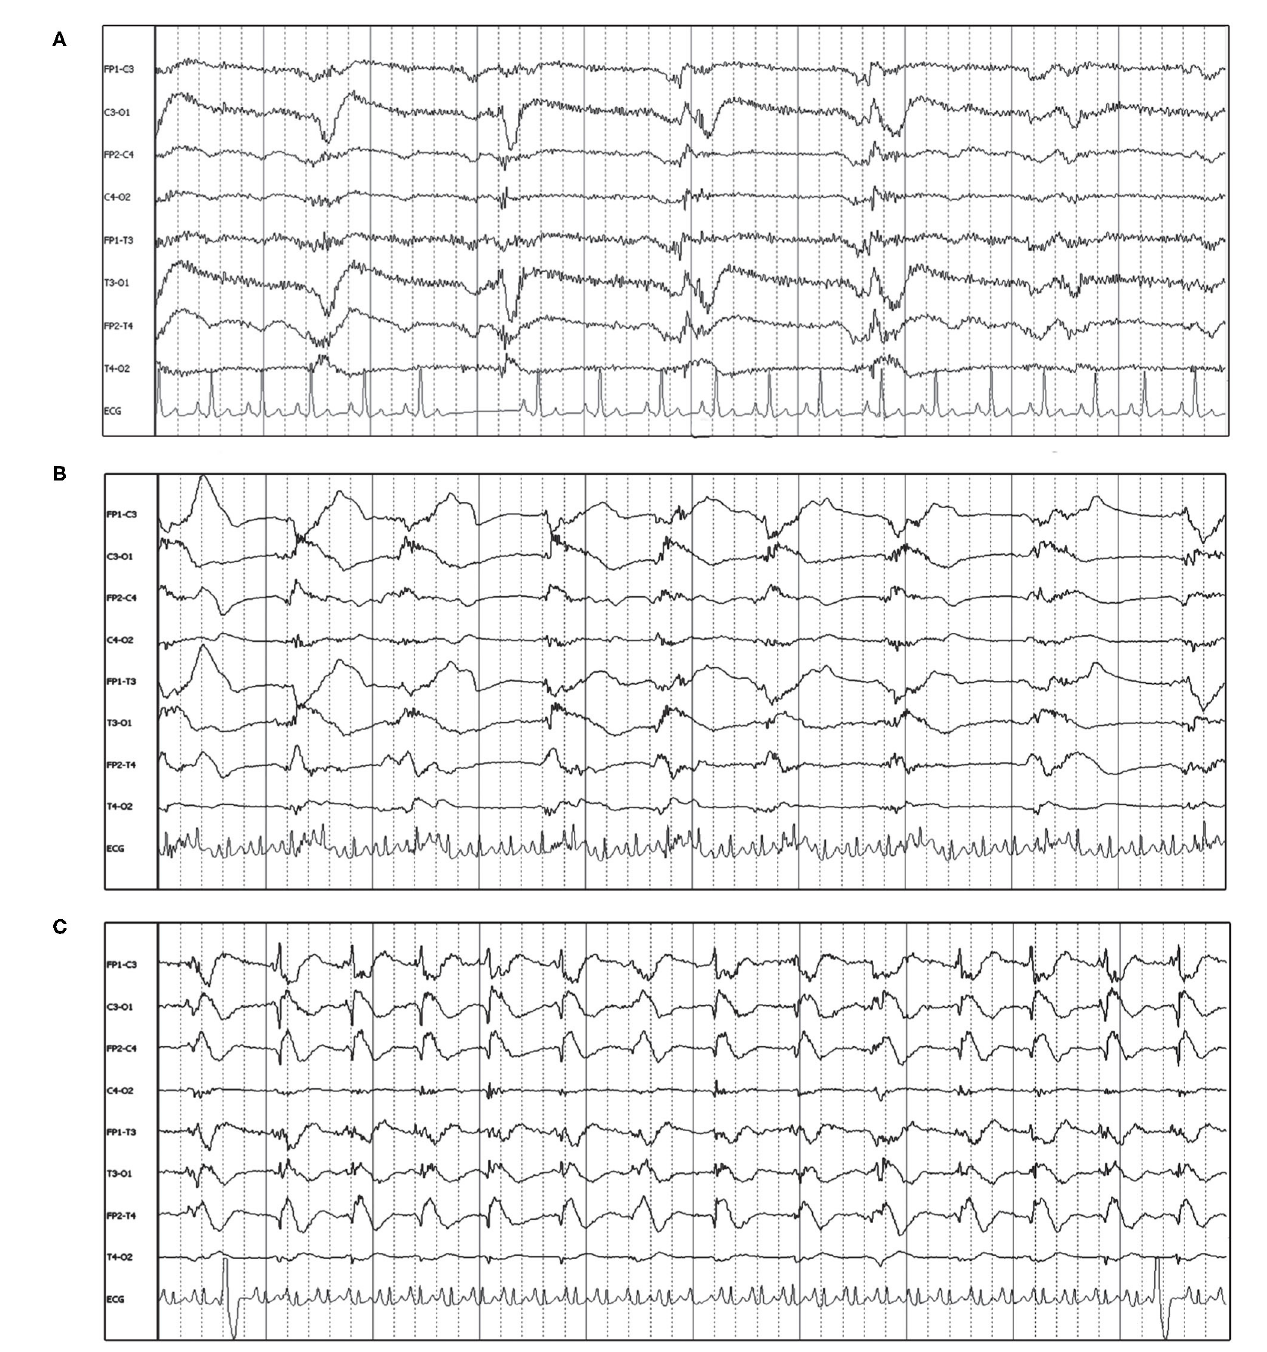
FIGURE4 EEG epochs over the course of 45min in a 10 year old Boxer with hypoglycemia and SE demonstrating evolution in PD frequency as well as change in morphology to a more ictal-appearing pattern. Bipolar montage. (A) PD frequency is about 0.5Hz, some with a triphasic morphology. There is no apparent phase reversal, but the discharge has the highest amplitude on the left side, and end-of-chain would localize to O1 (HF 35Hz, sensitivity 7 uV/mm). (B) Frequency increases to almost 1Hz, along with a change in morphology and increased amplitude—note the change in sensitivity. Discharges are still lateralized (LPDs), with phase reversal noted in the left hemisphere at T3 and C3 (HF 15Hz, sensitivity 50 uV/mm). (C) Frequency of PDs continues to increase to 1.5Hz, becoming more generalized and developing a spike-wave morphology, and the clinical diagnosis of electrographic seizure (ES) was made (HF 15Hz, sensitivity 30